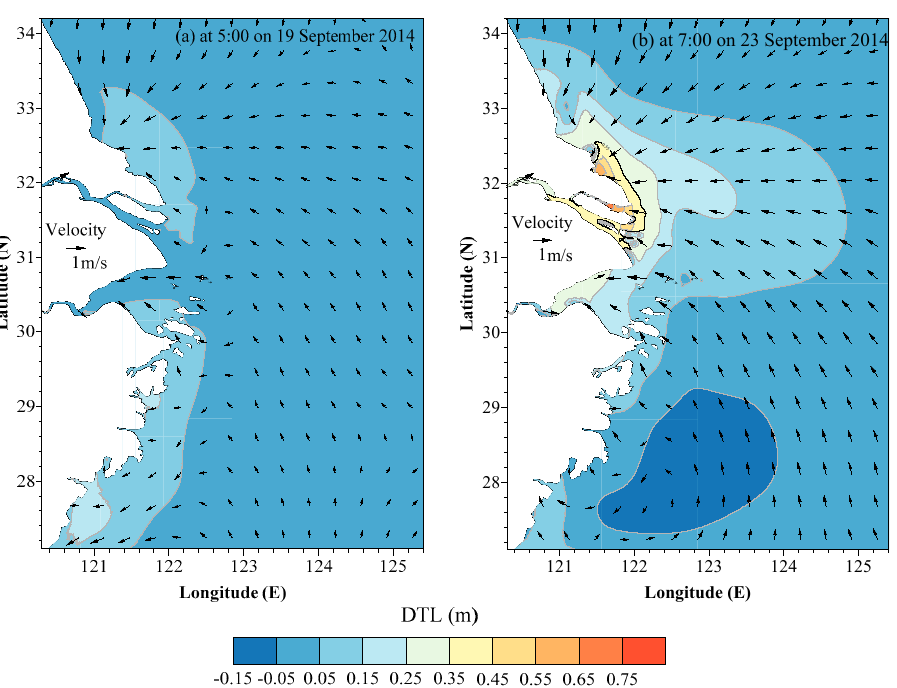
Figure 12. Contours of difference of tidal level (DTL) between typhoon and without typhoon and surface current velocity vector fields at 5:00 on 19 September 2014 ( a ) and at 7:00 on 23 September 2014 ( b ) with the strongest storm surge.